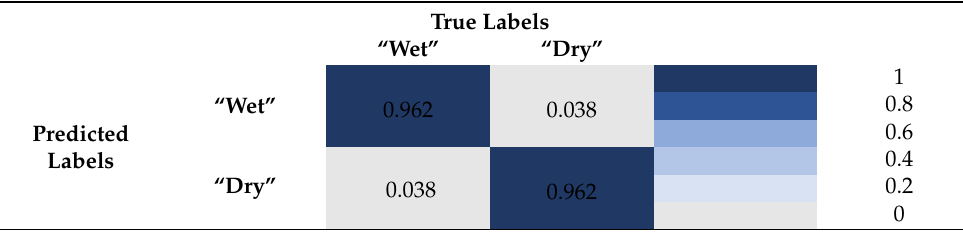
Table 2. Confusion matrix for test set 1 when results were compared with manually assigned labels.